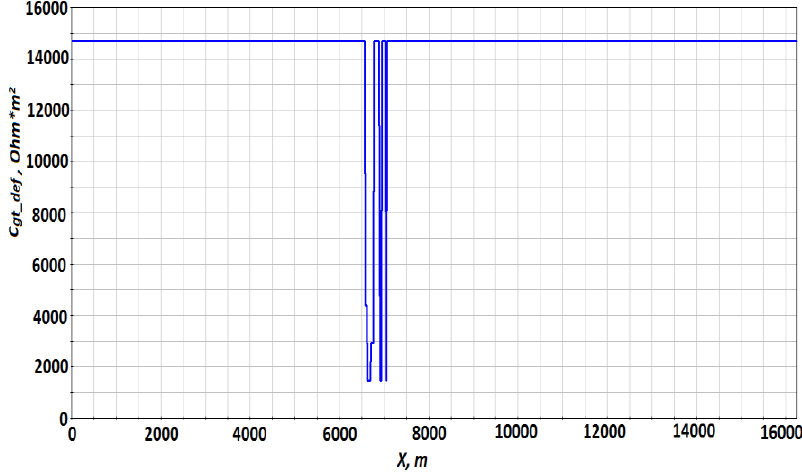
Figure 2. Given transition resistance of insulation (Ohm*m 2 ) at the boundary “ground/pipe”.